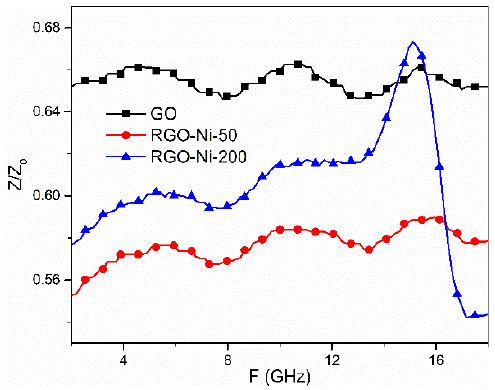
Figure 5. The impedance matching characteristics of GO, RGO–Ni-50, and RGO–Ni-200.